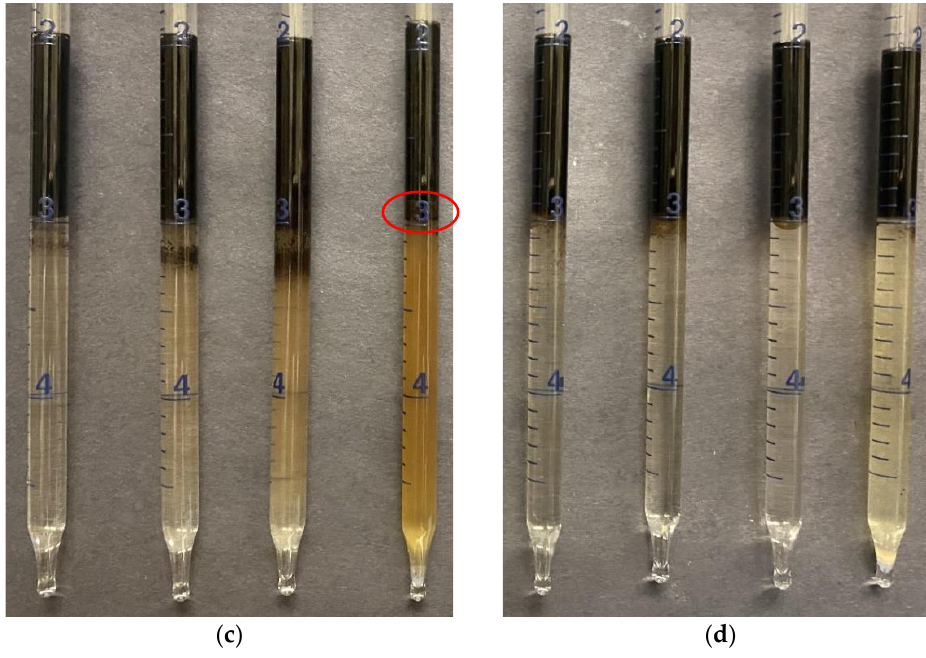
Figure 3. Emulsion tendency tests of APG with Unit-A and Unit-B crude oils at 45,000 (Left), 85,000, 144,000, and 180,000 (ppm) salinity (Right). ( a ) APG-Unit-A oil before mixing ( b ) APG-Unit-B oil before mixing ( c ) APG-Unit-A after mixing and resting for 2 days at 55 °C. ( d ) APG-Unit-B after mixing and resting for 2 days at 55 °C. Pipette graduations shown are in mL. The red circle in ( c ) highlights the thin layer of emulsions at 180,000 ppm.